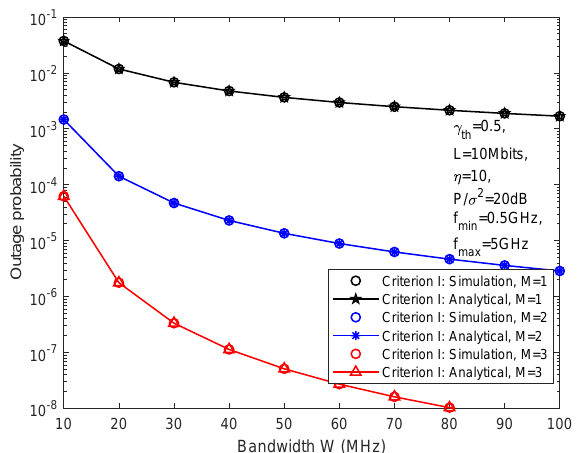
Figure 7. Outage probability versus bandwidth W for